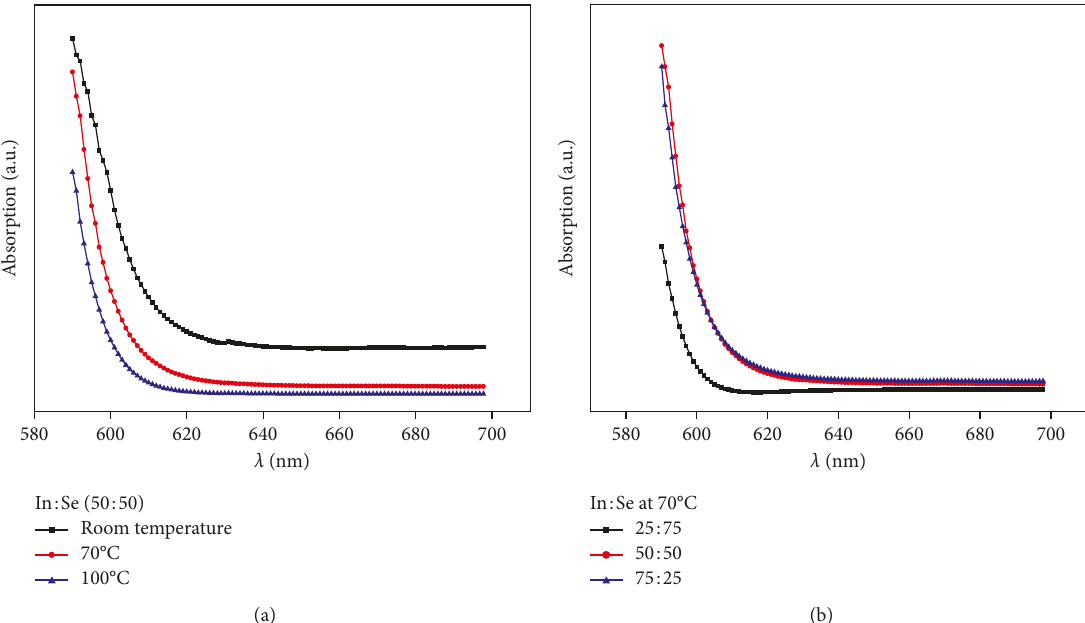
Figure 8: Optical absorption curves of InSe bilayer thin films for (a) 50:50 thickness ratio at (b) 70 ° C.